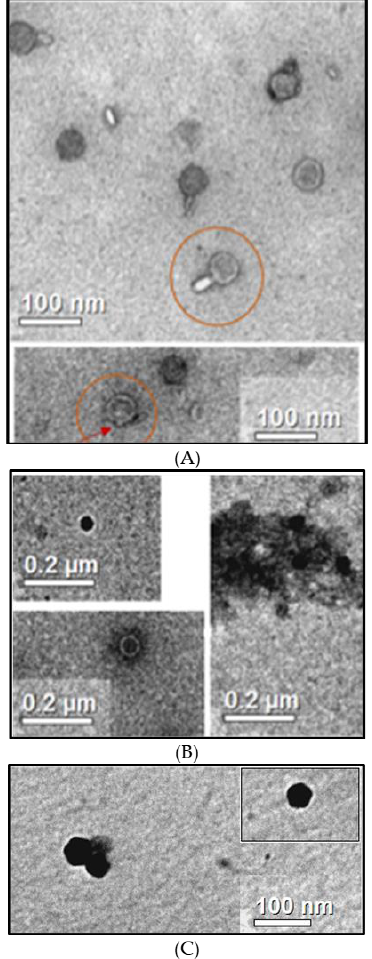
Figure 2. Transmission electron micrographs of phages 14.1 ( A ), LUZ7 ( B ), and B1 ( C ) stained with uranyLess. The circles show long tailed-particles and the arrow indicates the outgrowth replacing the original appendix lost by the vortexing step, limiting phage aggregate formation. The black color is probably due to positive staining.